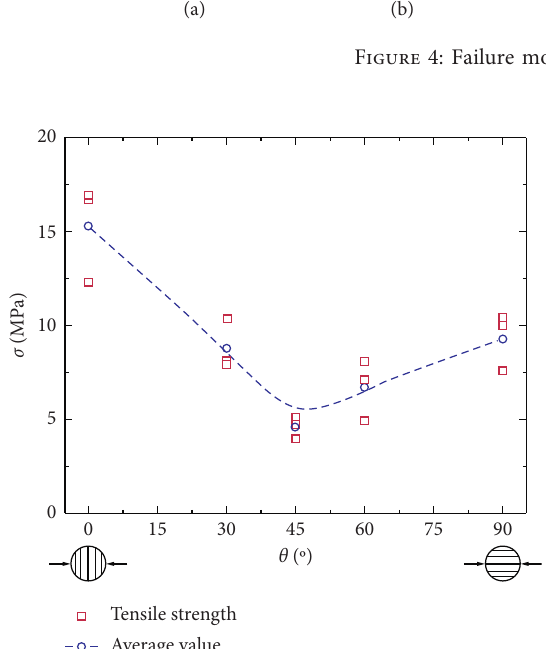
Figure 5: “Tensile strength” curve of the layered slate with different dip angles.